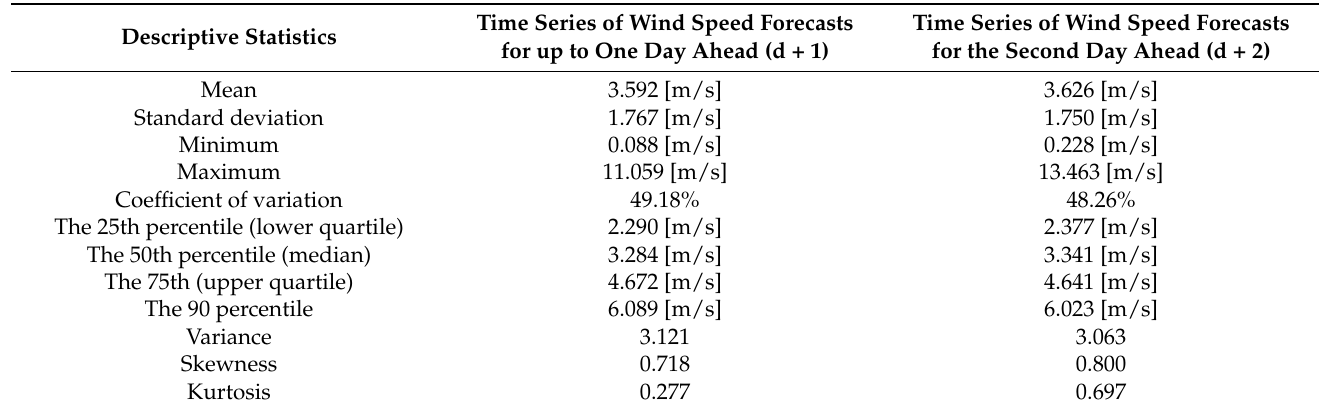
Table 2. Descriptive statistics of wind speed forecasts with horizons from 1 to 24 h and 25 to 48 h.